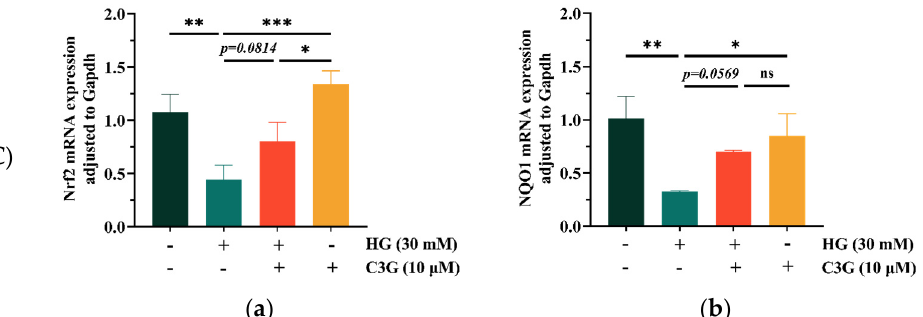
Figure 3. The antioxidant activities of the different blueberry extracts samples and monomer com- pound cyanidin-3- O -glucoside (C3G). ( A ) The Ferric-reducing antioxidant power (FRAP) ( a ) and DPPH radical scavenging capacity (DPPH) ( b ) of the different blueberry extracts samples; the con- centration of blueberry extracts samples was 200 μ M; ( B ) Effects of C3G treatment on GSSG ( a ) and GSH levels ( b ) in the ARPE-19 cells; ( C ) Effects of C3G treatment on the gene-expression of Nrf2 ( a ) and NQO1 ( b ) in the ARPE-19 cells. Data represent the mean ± standard deviation ( n = 3). Different letters were significantly different ( p < 0.05). (*) p ≤ 0.05, (**) p ≤ 0.01, and (***) p ≤ 0.001 compared with the high glucose (HG) only group.